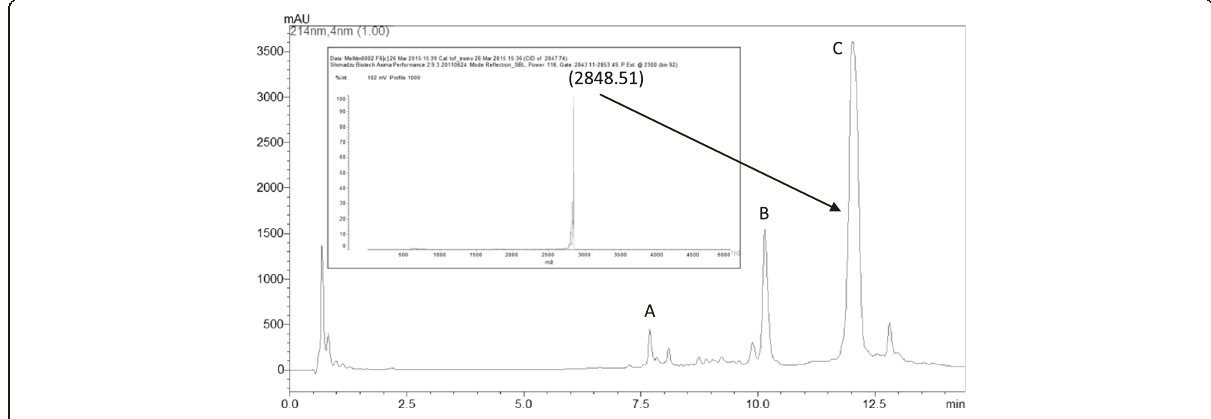
Fig. 1 Chromatographic profile of whole venom from Africanized honeybees obtained by reversed-phase liquid chromatography indicating its major components: ( a ) apamin, ( b ) phospholipase A 2 and ( c ) melittin. Inset: MALDI-TOF/MS profile of melittin (peak C). The m/z value is typed beside the peak for better